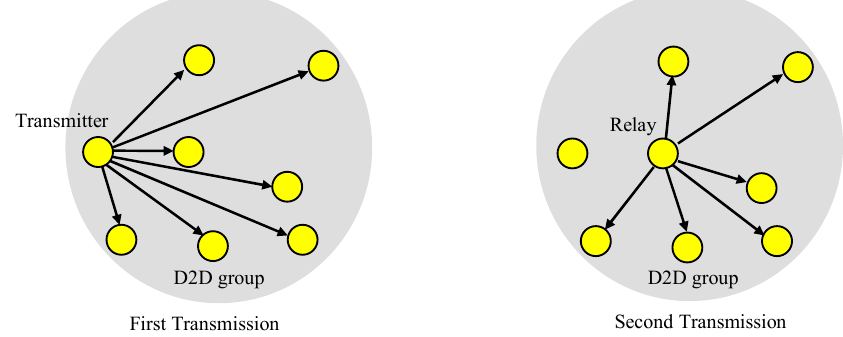
Figure 1. Device-to-device (D2D) group-casting with a relay.